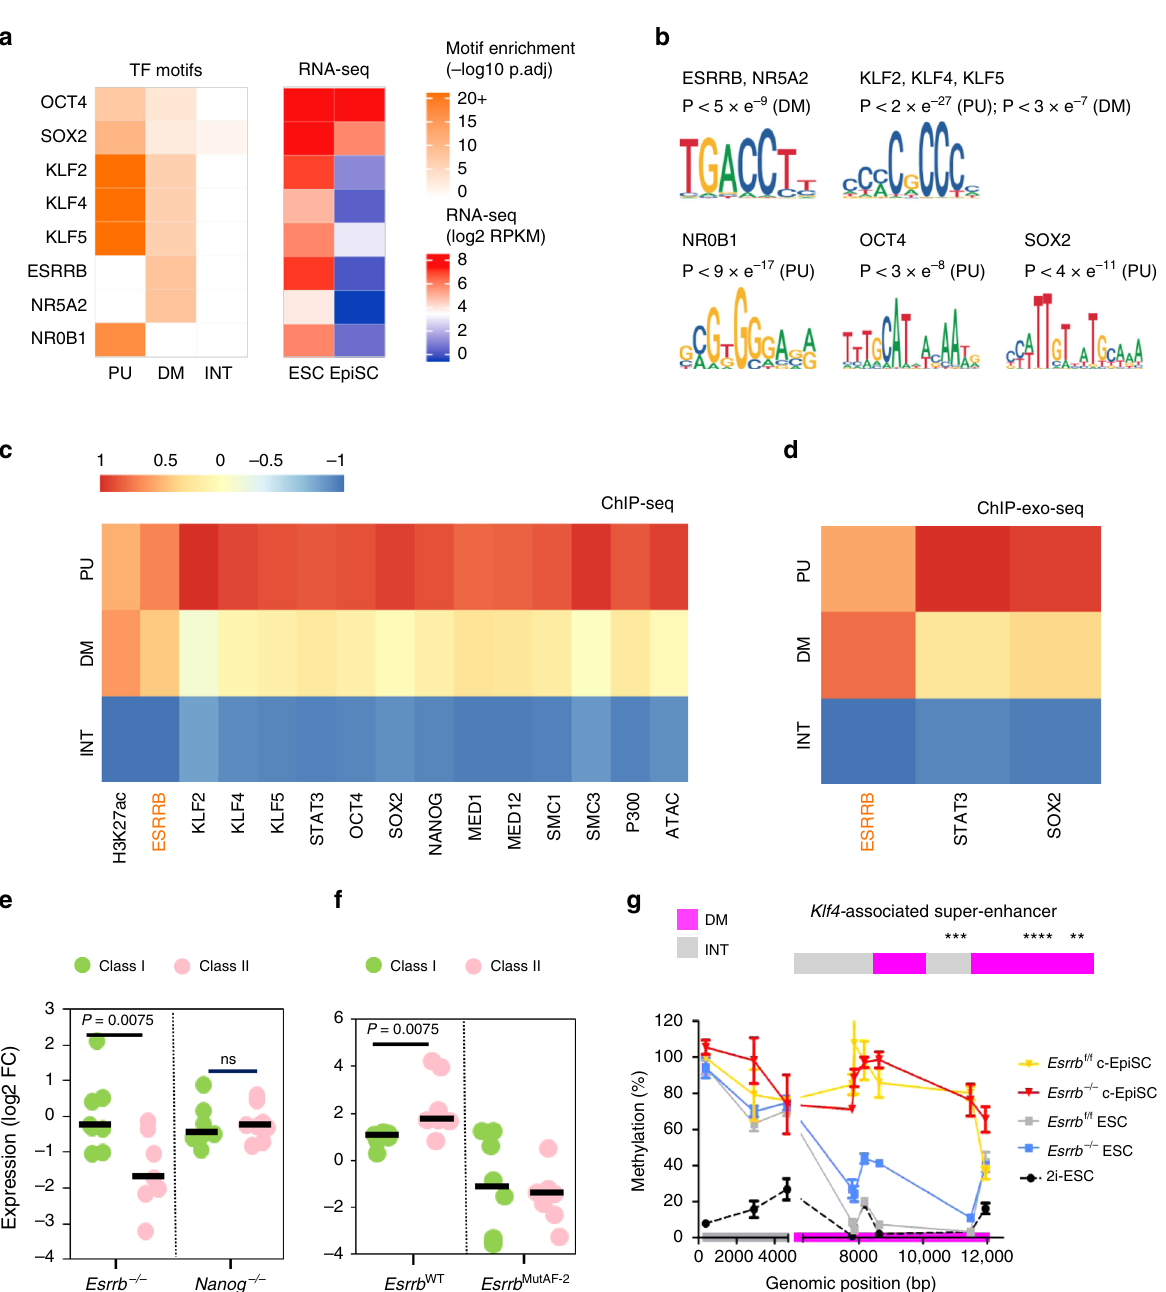
Fig. 5 DM subregions are most speci fi cally demarcated by high levels of ESRRB binding. a Transcription factor (TF) motif enrichment in PU, DM and INT subregions, and gene expression of corresponding TFs in ESCs (serum/LIF) and EpiSCs 25 . b Motifs and statistical enrichment (hypergeometric test, BH adjusted) for TFs shown in a . c Heatmap showing the relative enrichment levels (median log 2 fold change of ChIP-seq signal (RPKM + 1) over input signal (RPKM + 1)) at SE subregions in ESCs for TFs, co-regulators and chromatin accessibility (ATAC-seq). d Heatmap showing relative enrichment levels (calculated as in c ) at SE subregions in ESCs for ESRRB, SOX2 and STAT3-independent ChIP-exo datasets. Enrichment scores for each feature are scaled by dividing by the mean enrichment score for that feature across all subregions. See Supplementary Data 1 for dataset accession numbers. e Expression changes (RT-qPCR) relative to control ESCs of selected class I ( Oct4 , Smarcad1 , Otx2 , Lefty1 , Klf13 , Med13l , Tet1 and Nanog ) and class II ( Tfcp2l1 , Klf2 , Klf4 , Klf5 , Tdh , Tbx3 , Tet2 and Esrrb ) SE-associated genes in Esrrb- depleted ( − / − ) and Nanog − / − ESCs. Medians are indicated by bars. Mann – Whitney test was used to compare class I (light green) and class II (pink) expression behaviour. f Expression changes (RT-qPCR) in WT or MutAF-2 transfected Esrrb − / − ESCs relative to empty vector are shown for selected class I and class II SE-associated genes as in a . Data represent three independent experiments ( n = 3). g CpG methylation at different CpG positions (asterisks) within DM (magenta) and INT (grey) subregions of the Klf4 -associated SE in Esrrb − / − (blue) and control ( f/f ; grey) ESCs and corresponding converted EpiSCs (c-EpiSCs; red and orange, respectively), as well as in control ESCs cultured in 2i/LIF (2i; black dashed). The pro fi le of Esrrb − / − ESCs was not analysed in 2i/LIF due to loss of cell viability as previously reported 50 . Data are means ± s.e.m. of three independent experiments ( n = 3). Source data are provided as Supplementary Data